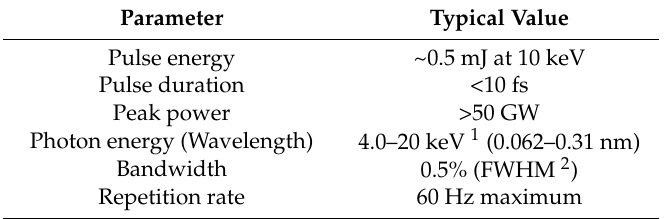
Table 1. Typical characteristics for the X-ray Free Electron Laser (XFEL) light of beamline 3